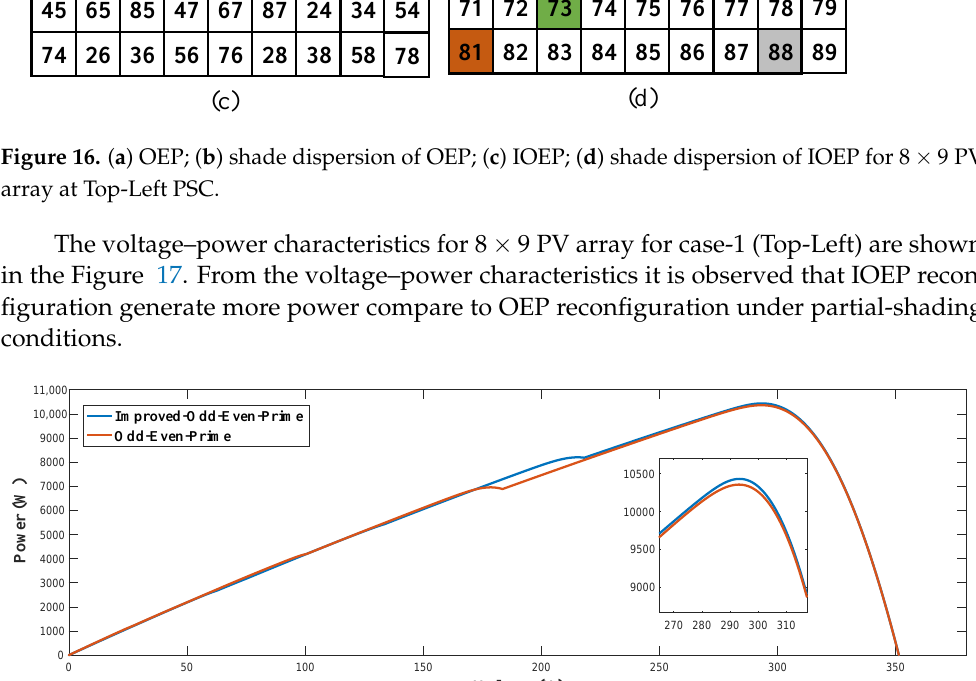
In Case-2, in the Top-Right corner, 16 PV modules are partially shaded, as seen in the Figure